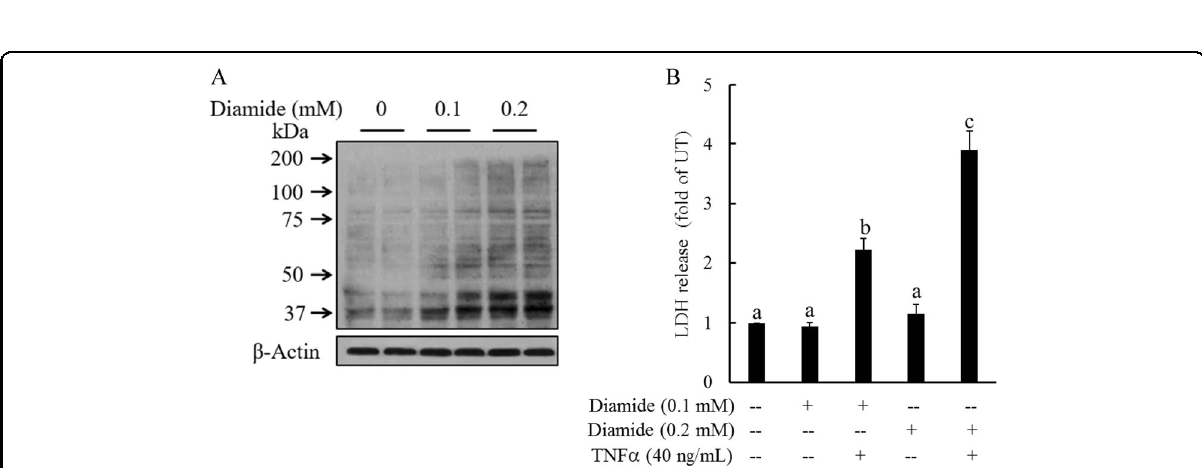
Fig. 5 Increased cellular protein S -glutathionylation sensitizes hepatocytes to TNF α hepatotoxicity. a Diamide, a protein S -glutathionylation induction agent, increased intracellular protein-GSSG adduct formation. HepG2 cells were incubated with exogenous diamide (0.1 and 0.2 mM) for 2 h. Whole-cell lysates were collected and used for the detection of the intracellular GSSG levels by western blot analysis. b Diamide pretreatment sensitized hepatocytes to TNF α -induced cell death. HepG2 cells were pretreated with diamide (0.1 and 0.2 mM) for 2 h before TNF α (40 ng/mL) addition. Cell death was measured by the LDH assay 16 h later. All values are expressed as the mean ± SD from three or more independent studies. Bars with different characters differ signi fi cantly ( p <